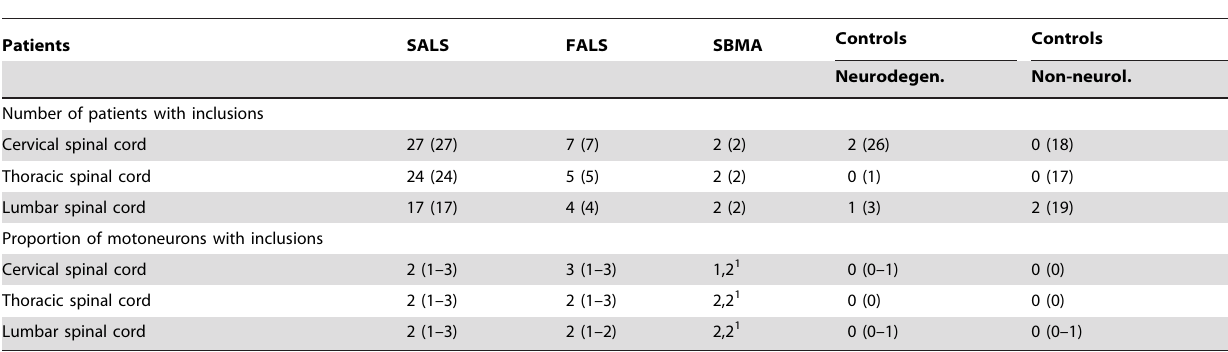
Table 1. Immunohistochemical